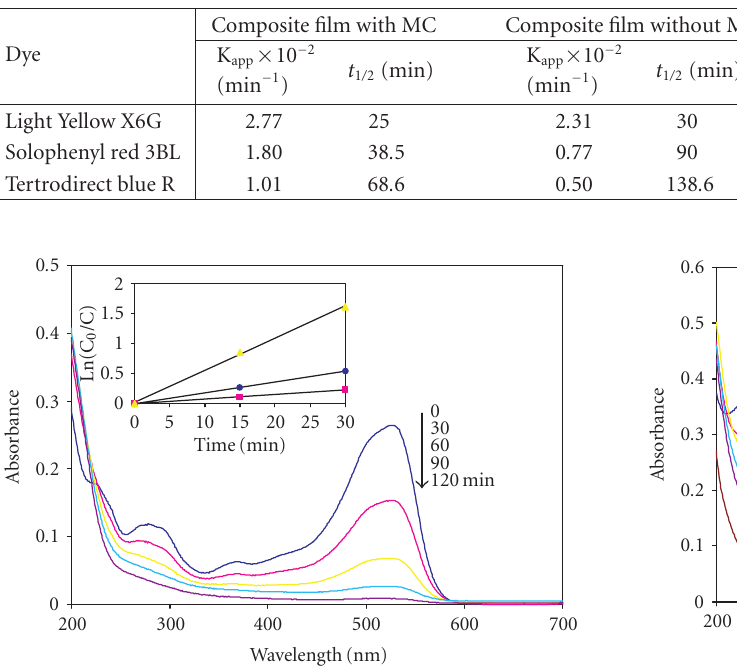
Table 3: Pseudo-first-order kinetic parameters of three diazo dyes photocatalytic degradation .